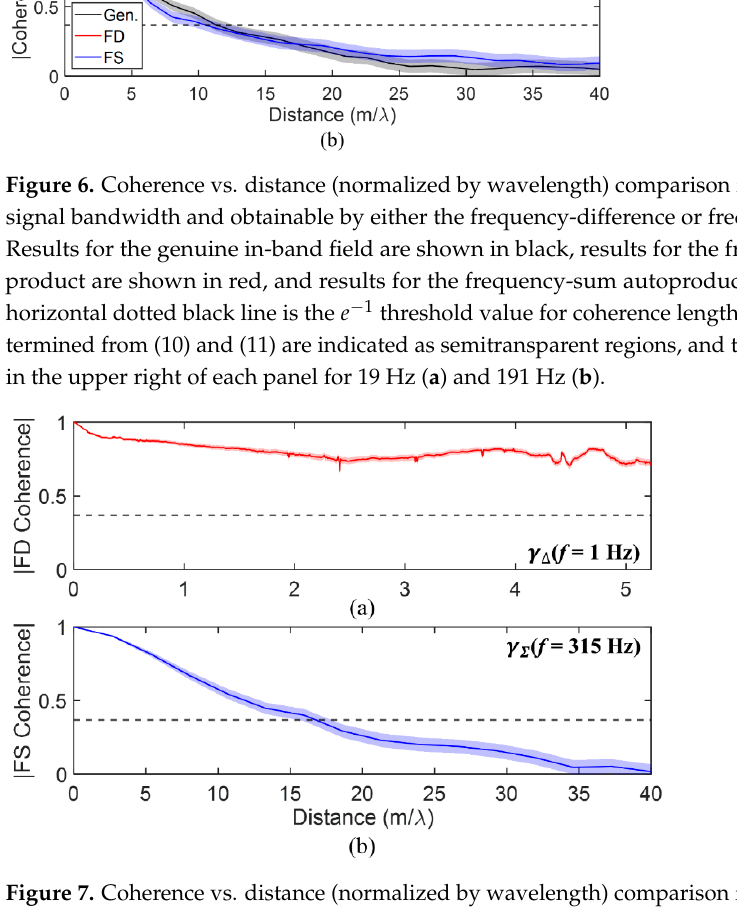
Figure 7. Coherence vs. distance (normalized by wavelength) comparison for frequencies obtainable only by the frequency-difference or frequency-sum autoproduct. The frequency-difference autoproduct is shown in red in ( a ) and the frequency-sum autoproduct is shown in blue in ( b ). The horizontal dotted black line is the e − 1 threshold value for coherence length. Confidence intervals using (10) and (11) are indicated as semitransparent regions, and the frequency used is displayed in the upper right of each panel.